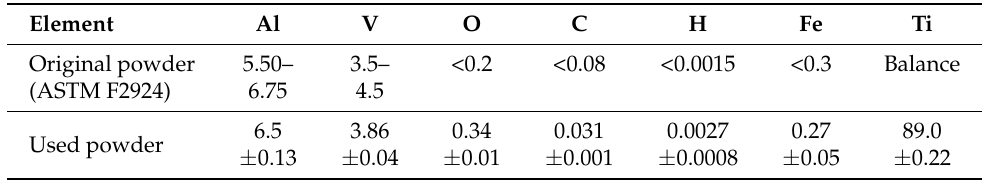
Figure 2. Ti-6Al-4V specimen fabricated by the EB-PBF process. The size of each rod sample is φ 11 mm × 70 mm. Table 1. Chemical compositions of the Ti-6Al-4V powder